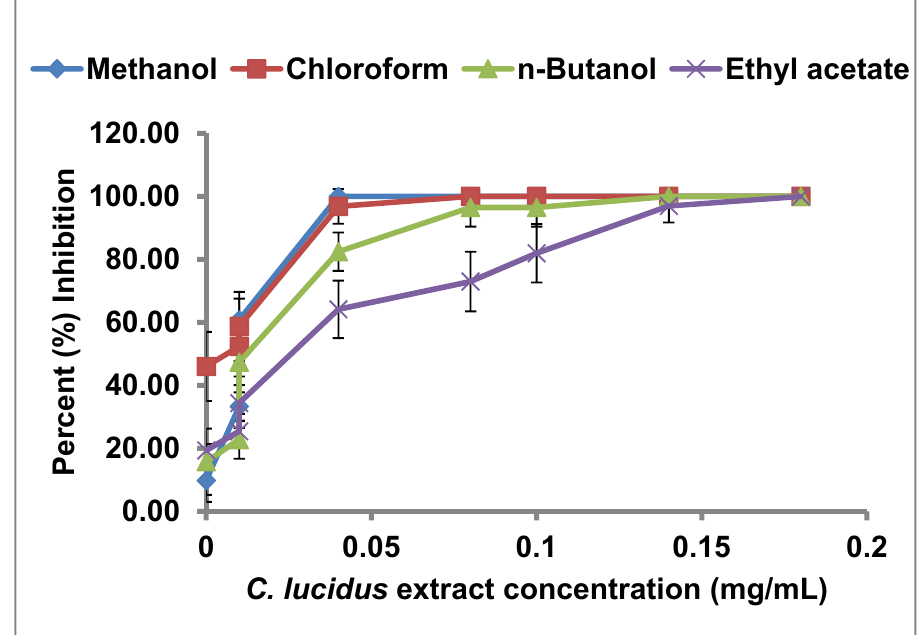
Figure 2. Dose-response curves of different partitions of C. lucidus crude leaf